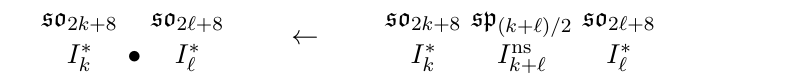
I (cid:3) and n +4 b